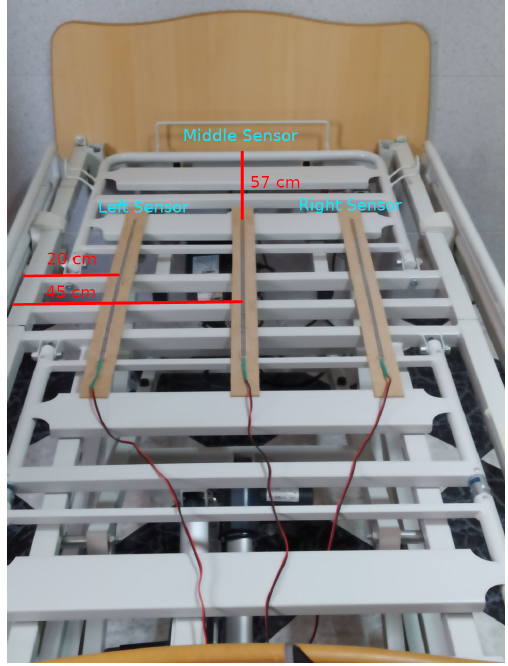
Figure 3. Location of sensors under the bed.